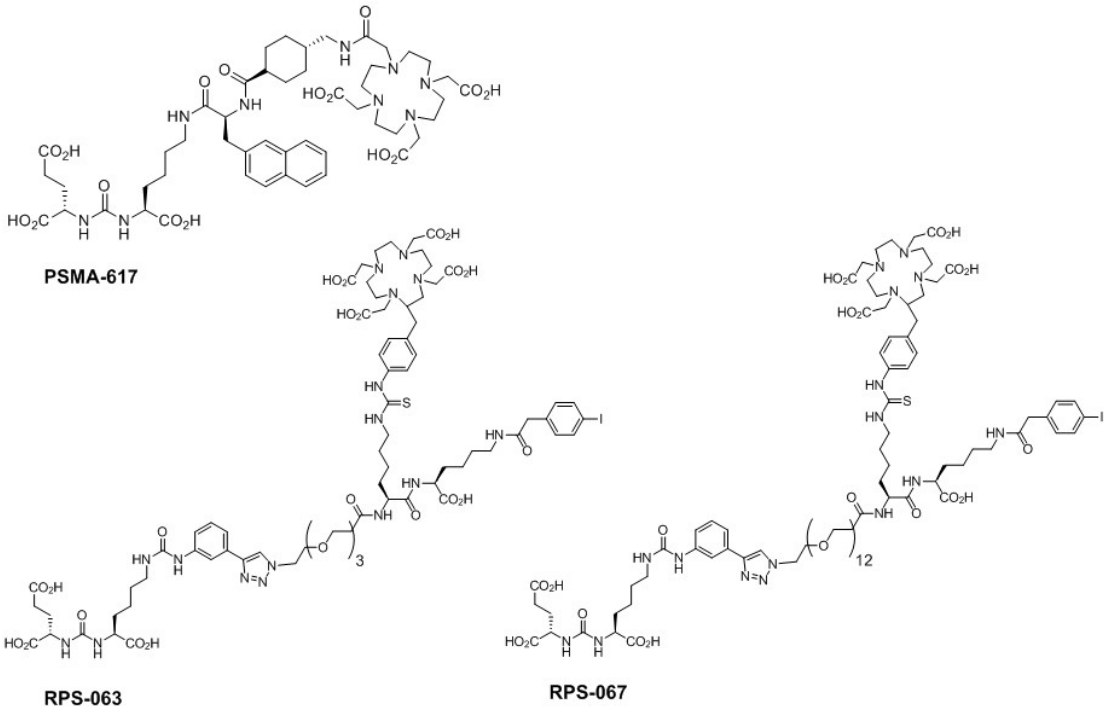
Figure 5. Structures of PSMA-617, RPS-063, and RPS-067.